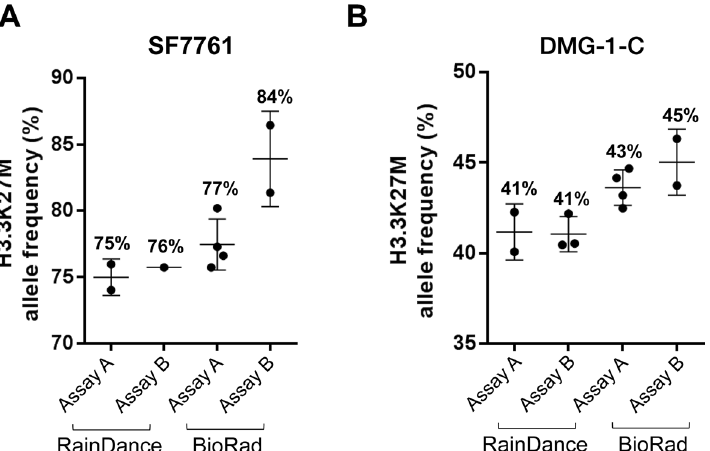
Figure 4. ddPCR results are consistent across institutions, irrespective of specimen preparation location. To determine the effects of location of sample DNA extraction and specimen shipment on ddPCR analysis results, DNA was extracted from ( A ) H3K27M mutant DMG CSF (DMG-1-C), and ( B ) DMG cells (SF 7761) at NU. ctDNA was pre-amplified using Assay C primers (NU), then analyzed on BioRad (NU) and RainDance (CN) platforms, with results compared to those from ctDNA extracted at CN. As with CN-prepared specimens, NU-prepared specimens yielded greater relative positive droplet counts in cell-derived ctDNA compared to CSF, and on RainDance compared to BioRad, with consistent droplet counts and MAFs between assays within a given platform. % values = Mutation Allelic Frequency